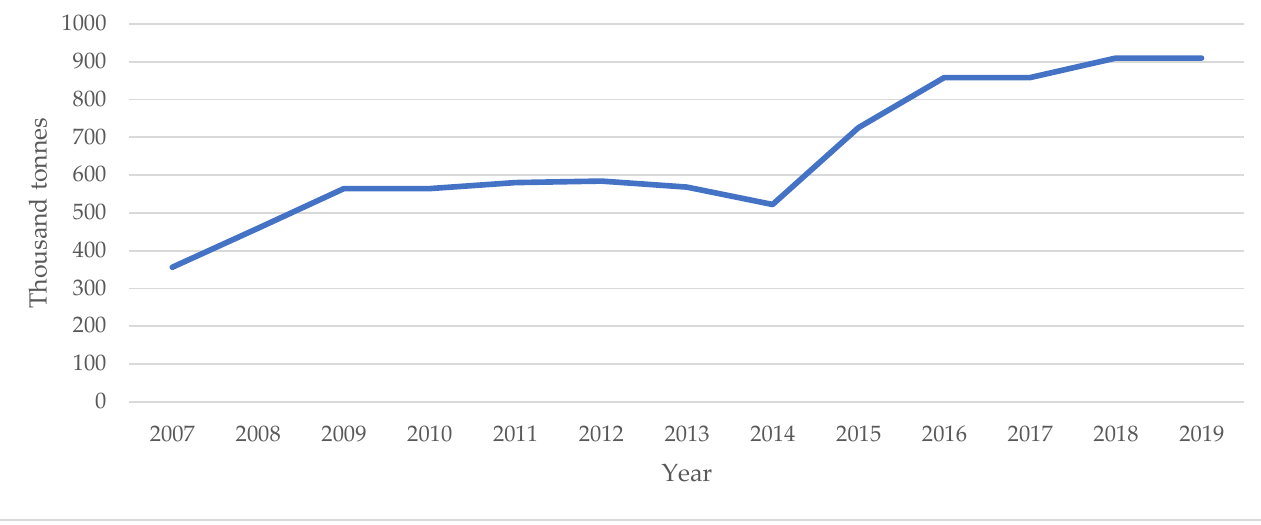
Figure 4. Pure biodiesel production in Poland in 2007 – 2019 (thousand tons). Source: own elaboration based on Eurostat data [55].